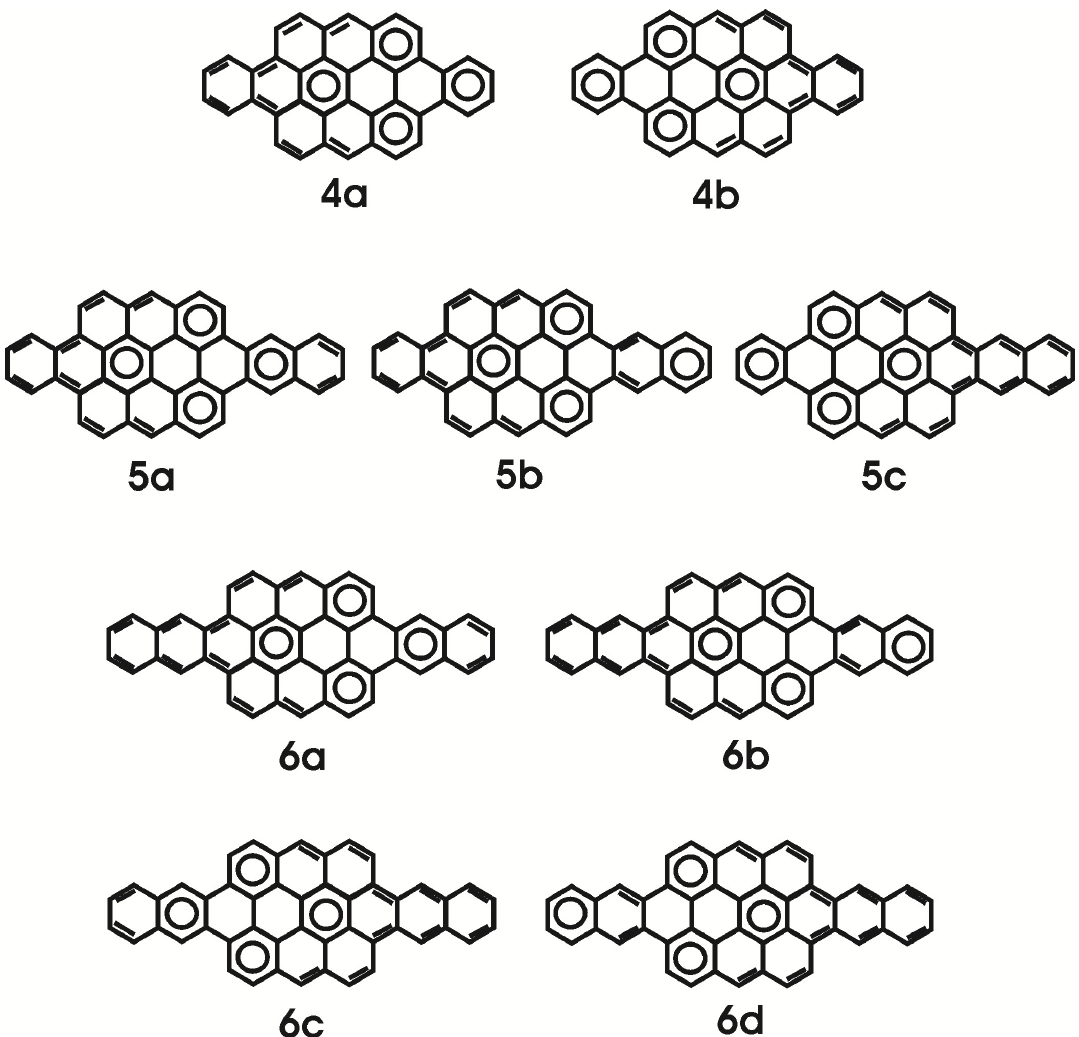
Fig. 3 – 4a and 4b are two of the 20 Clar formulas of dibenzo[ d,o ]ovalene ( 4 ); 5a , 5b , and 5c are three of the 34 Clar formulas of benzo[ o ]naphthaleno[ d ]ovalene ( 5 ); 6a , 6b , 6c , and 6d are four of the 57 Clar formulas of dinaphthaleno[ d,o ]ovalene ( 6 ). These are the Clar formulas in which an aromatic sextet is located in the rings 9 or 10, implying that the magnitude of cyclic conjugation in these rings is greater than in ovalene ( 1 ). This prediction of Clar theory is erroneous (cf. Table